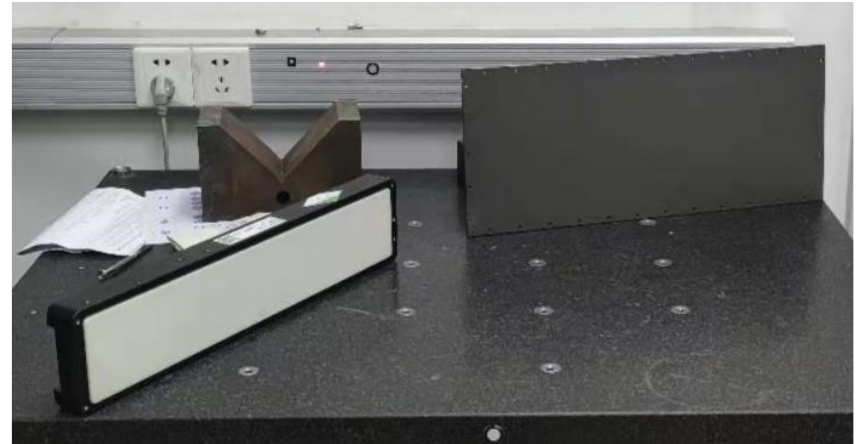
Figure 9. The photographs of the metal plane and white ceramics plane. As shown in Figure 10, the measured surface is re-constructed by the obtained point cloud shown using the best fitting plane. The fitting flatness of the measured plane is 0.345 mm, with 138,681 points, and the standard deviation and RMS are both 0.077 mm. GD&T’s evaluation standard uses ASME Y14.5 2009.